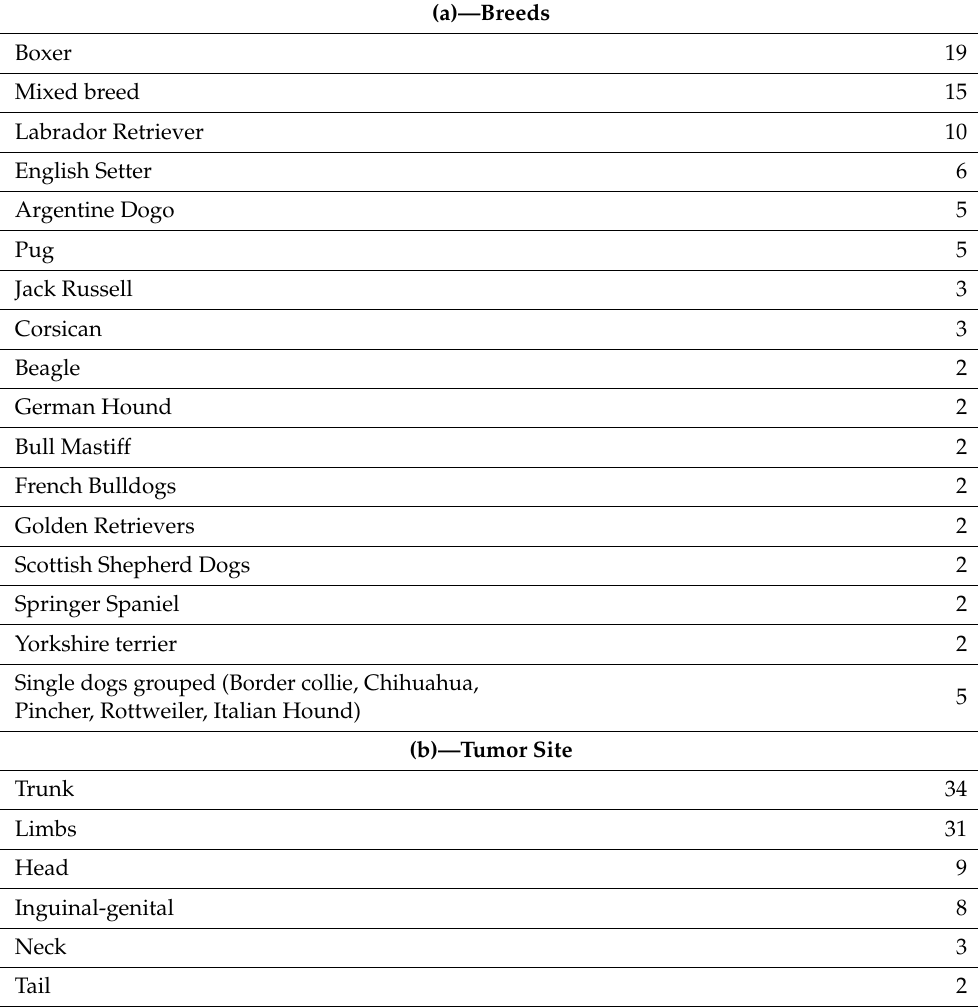
Table 1. Details of the breeds with MCTs selected for the study (a), and list of the tumor sites